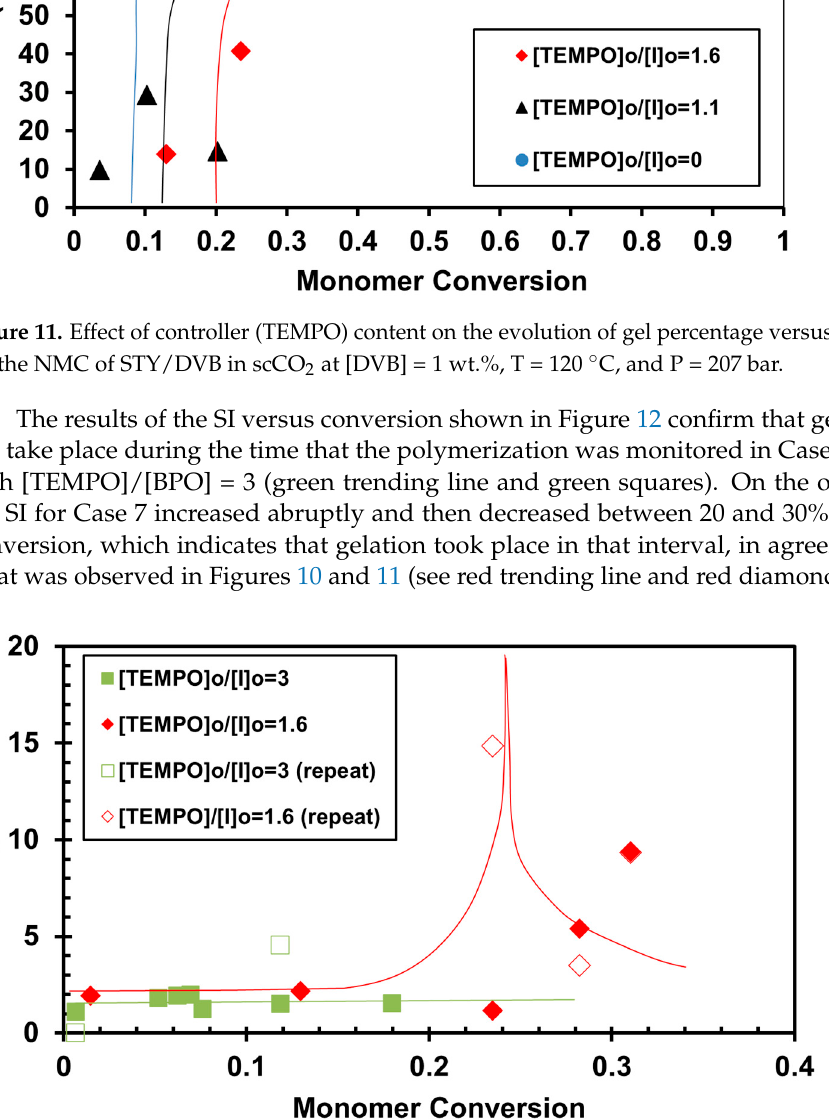
Figure 10. Effect of controller (TEMPO) content on the evolution of M w versus conversion for the NMC of STY/DVB in scCO 2 at [DVB] = 1 wt.%, T = 120 °C, and P = 207 bar.